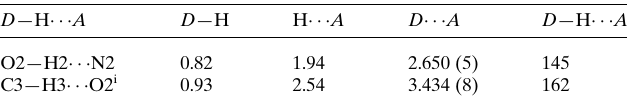
Table 1 Hydrogen-bond geometry (A˚ , (cid:3) ).